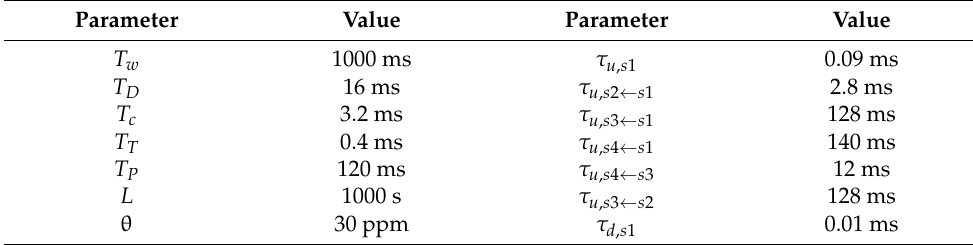
Table 3. Power states and Time used in the sleep